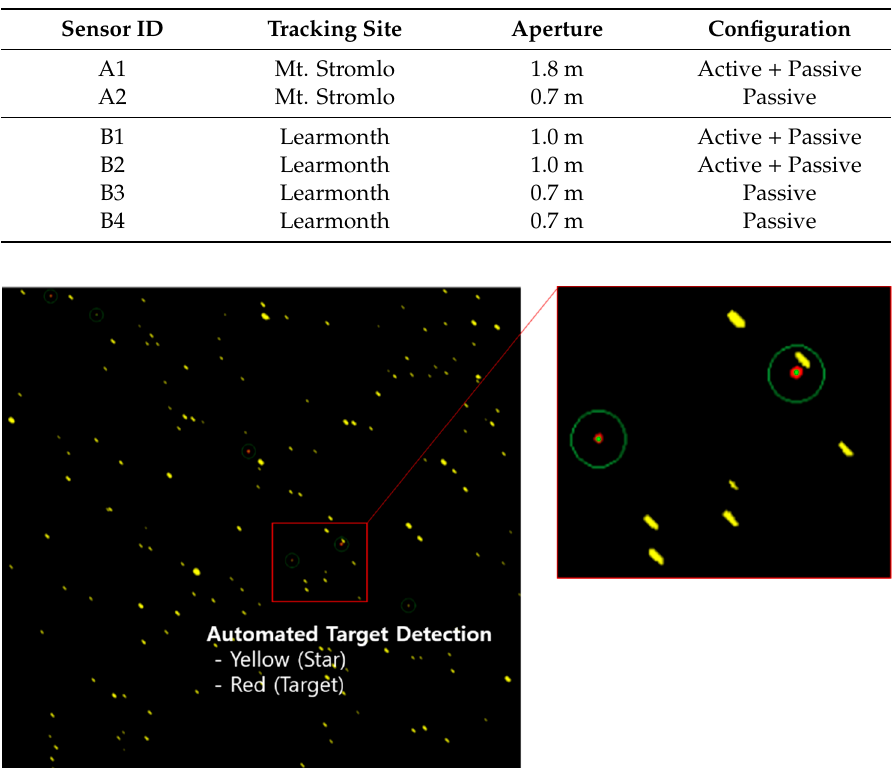
Table 3. The configurations of two tracking sites [15].